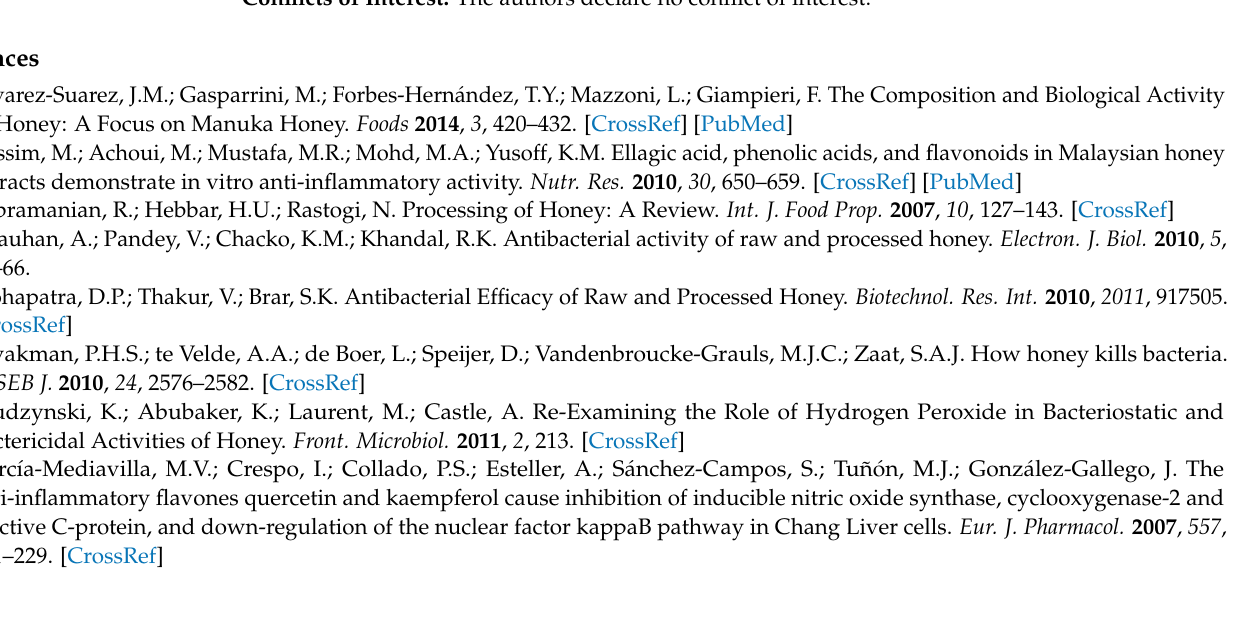
Table S1: Table of Values—Activity of honey samples and controls with E. coli , B. subtilis , M. luteus , S. epidermidis , and L. acidophilus ; Table S2: Nitric oxide production by Raw 264.7 cells ( µ M) when exposed to honey samples (1–100 µ g/mL) and controls; Table S3: Percent inhibition of TNF −